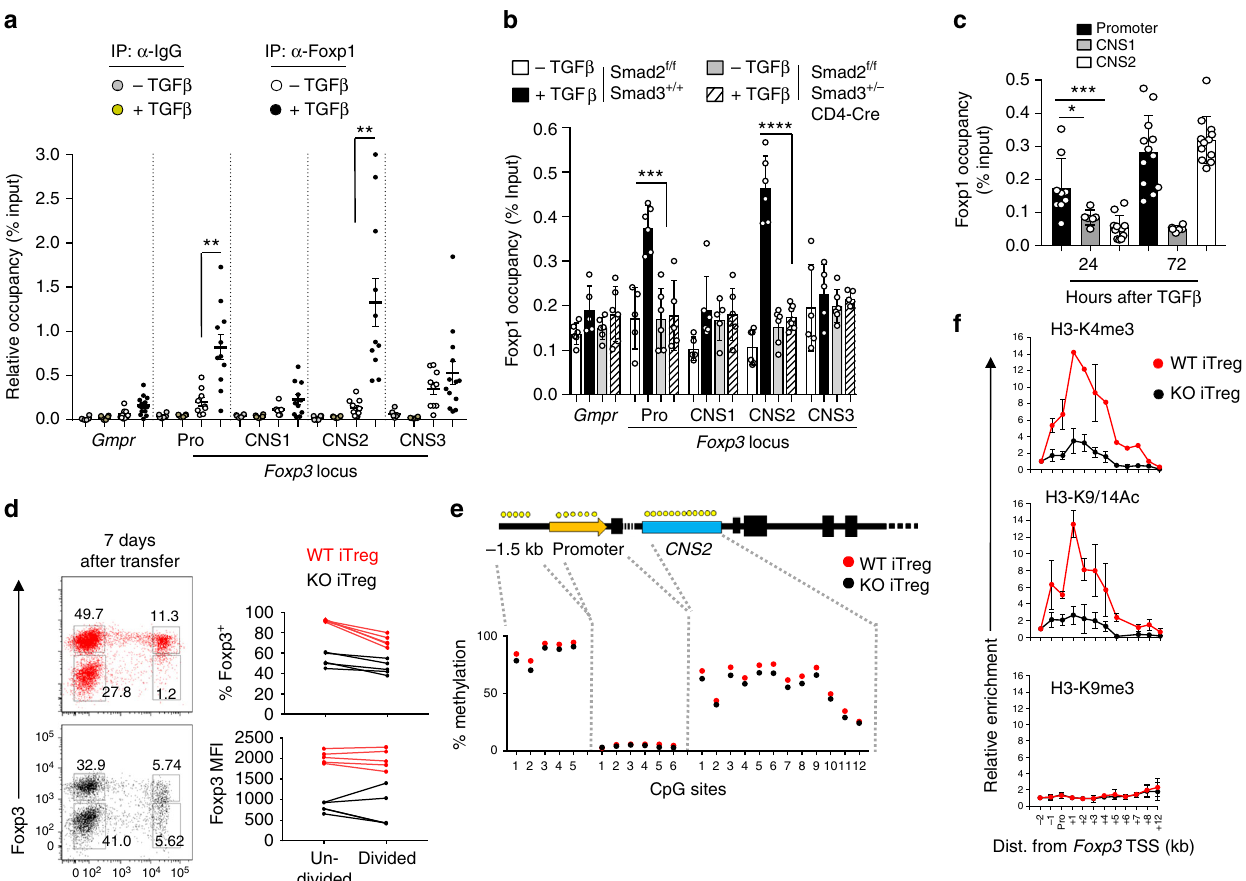
Fig. 5 Foxp1 binds to Foxp3 locus and retains permissive histone modi fi cations. a Sorted CD4 + Tnv cells from Foxp3 IRES-Thy1.1 mice were activated in vitro in the presence or absence of TGF- β for 3 days. ChIP analysis was performed with either anti-Foxp1 or normal rabbit IgG (control) antibody. Data are shown as a relative enrichment of immunoprecipitated DNA corresponding to Foxp3 gene locus over Input. Gmpr serves as negative control. Data representative of at least four independent experiments. * P < 0.05, ** P < 0.01, *** P < 0.001, **** P < 0.0001 (Student ’ s t test, error bars, s.e.m). b ChIP analysis with